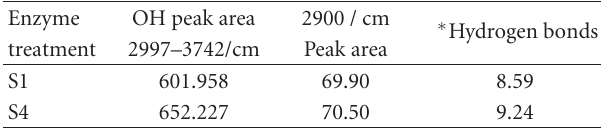
Table 2: Change in IR Index of D 2 O-saturated wood fire with enzymatic treatment: OH peak from 2997 to 3724/cm.